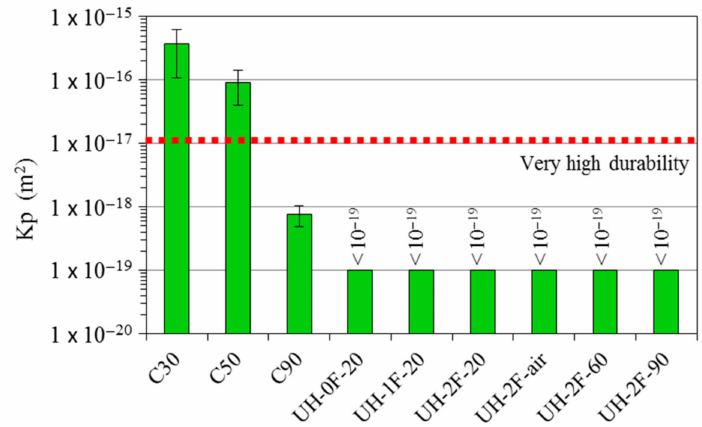
Figure 16. Oxygen permeability coefficient (K p